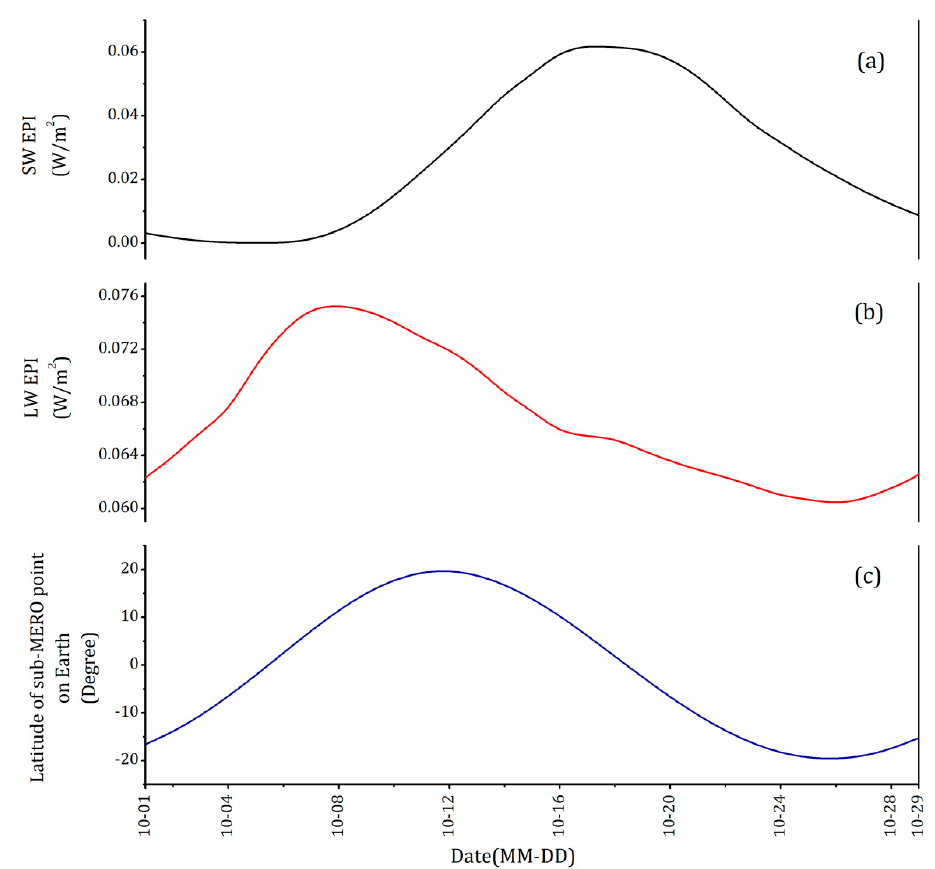
Figure 7. SW ( a ), LW ( b ), entrance pupil irradiance (EPI) and the latitude of the sub-MERO point on Earth ( c ), of the hypothetic MERO located at the Apollo 15 landing site over about the Moon’s orbital period from October 1 to October 29, 2017.